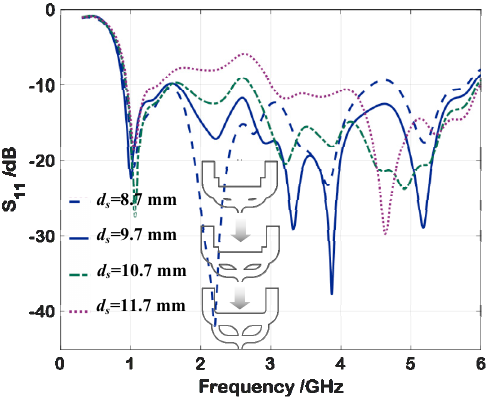
Figure 5. Simulated reflection coefficient of the proposed antenna B with different distances ( d s ) between the two stubs.